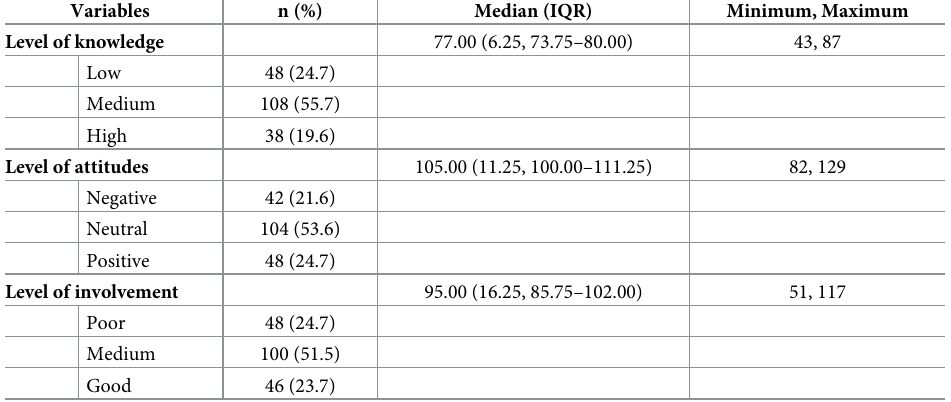
Table 2. Knowledge, attitudes and involvement of Health Promoting School program among high school